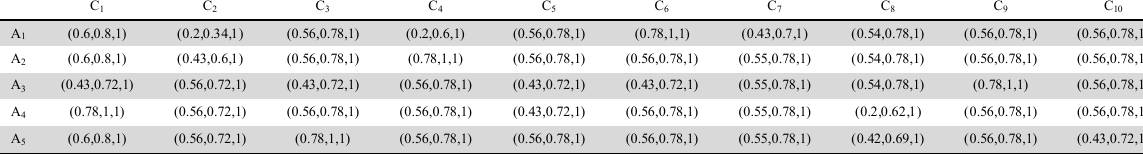
Normalized weighted fuzzy decision matrix for supplier evaluation